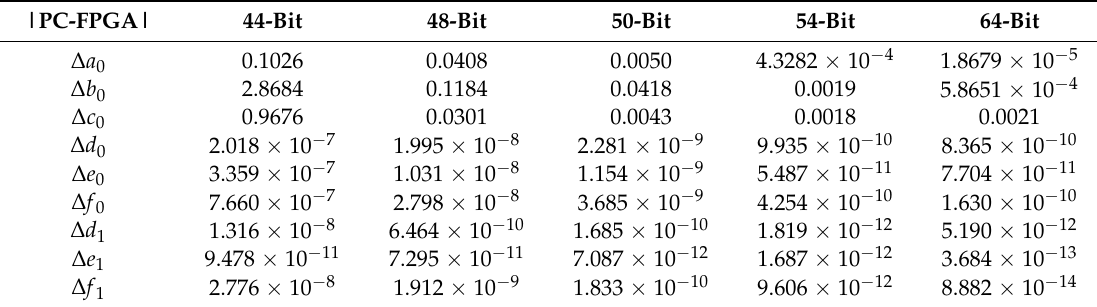
Table 3. Differences of the results computed by FPGA-based and PC-based computations with various data